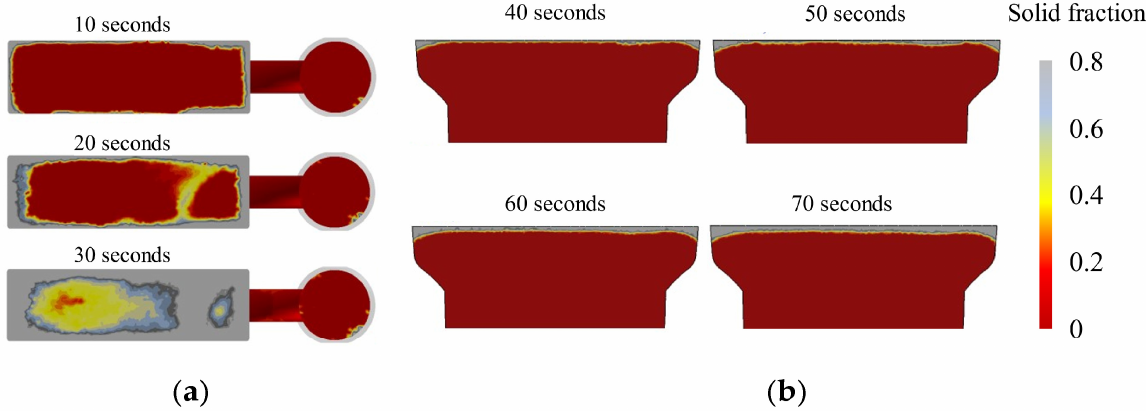
Figure 8. Simulated interfacial solid fraction for different pouring time intervals: ( a ) top and ( b ) side